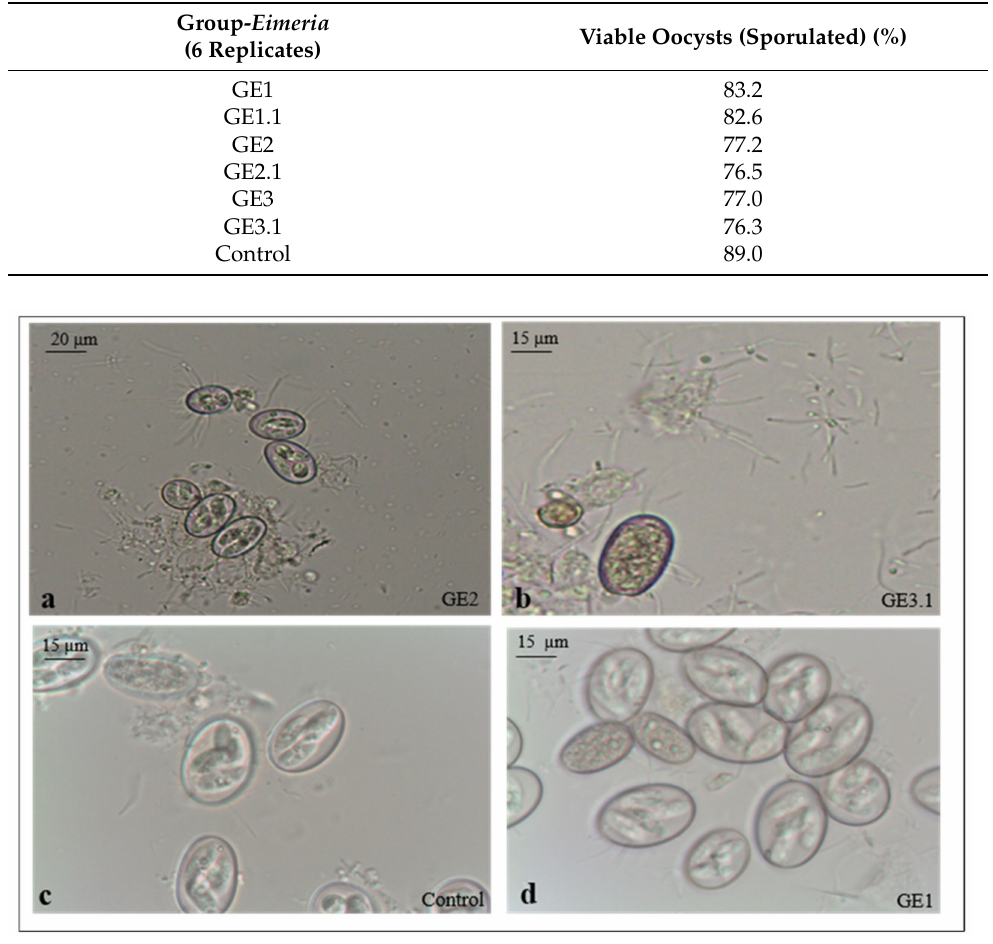
Figure 2. Presence of bacteria in the GE2 and GE3.1 treated groups ( a , b ) and in the control group ( c ); oocysts at early cytoplasmatic stage ( d